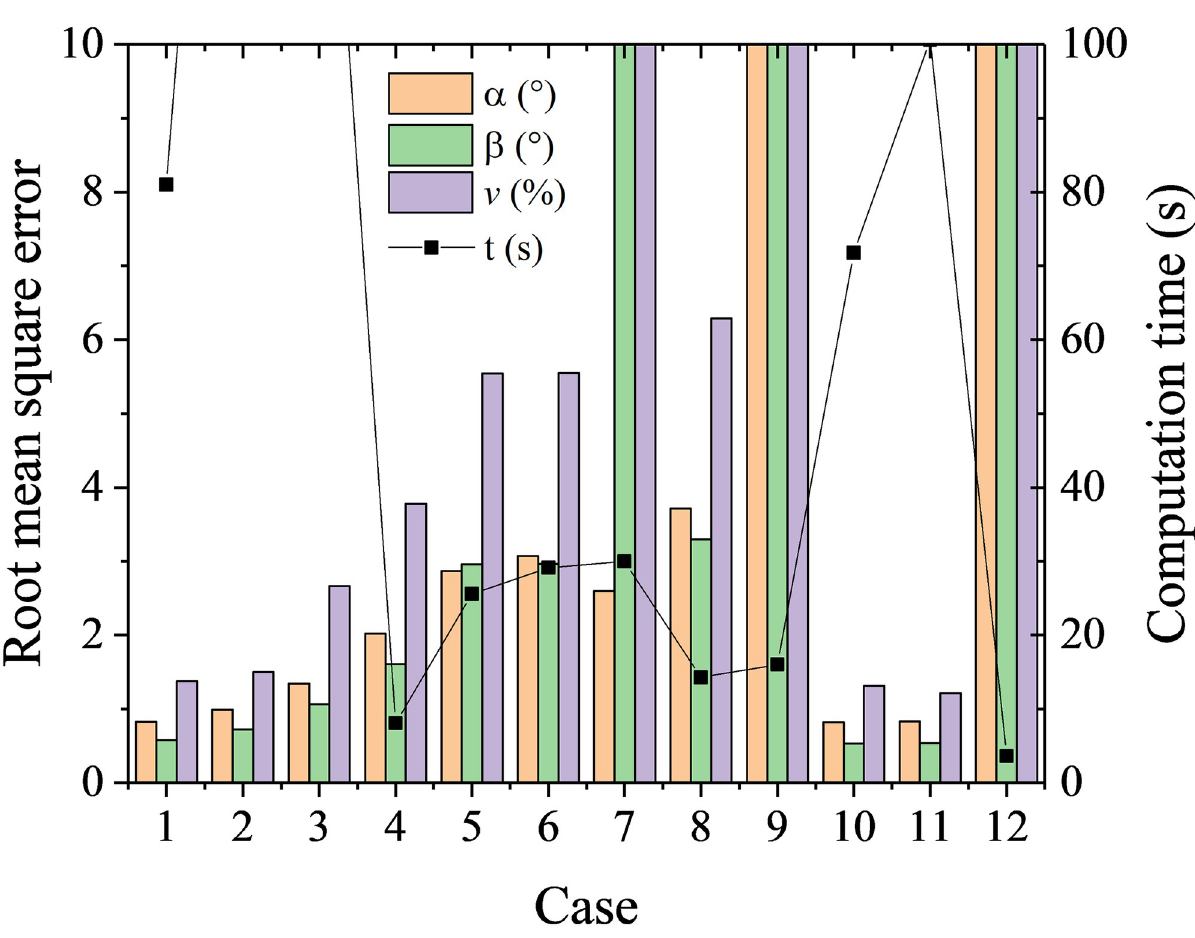
Fig 8. RMSEs and computation time at different cases with multi-layer perceptron.